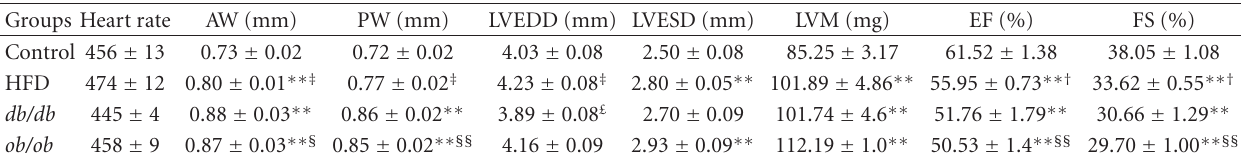
Table 2: Echocardiographic results. Anterior wall thickness, posterior wall thickness, left ventricular end diastolic dimension, left ventricular end systolic dimension, left ventricular mass, ejection fraction, and fractional shortening were measured. Data reported as mean ± SE. Results of ANOVA, followed by post hoc t -tests: ∗ P < 0 . 05, ∗∗ P < 0 . 01 compared with the control group; † P < 0 . 05, ‡ P < 0 . 01 (HFD versus db/db ); § P < 0 . 05, §§ P < 0 . 01 (HFD versus ob/ob ); £ P < 0 . 05, P < 0 . 01 ( db/db versus ob/ob ).